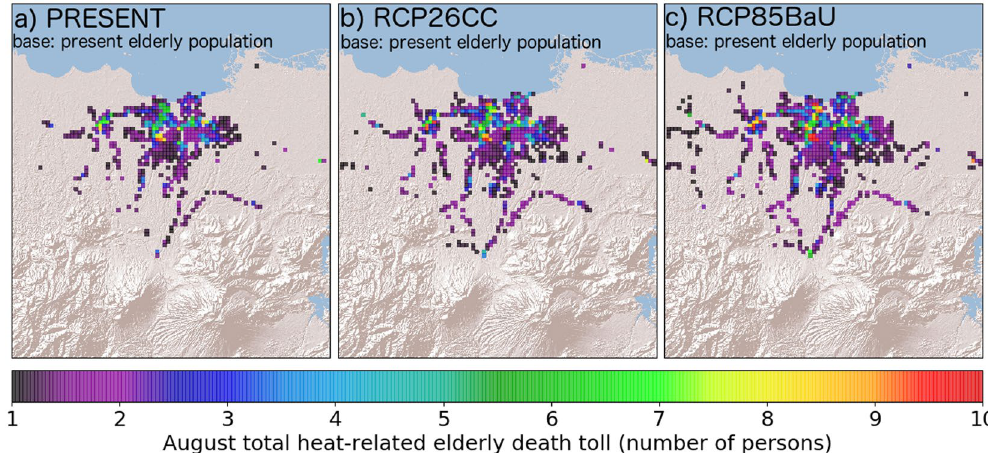
Figure 2. Estimated heat-related elderly mortality count when exposing the present-state population of elderly citizens to maximum temperatures simulated in ( a ) PRESENT, ( b ) RCP26CC, and ( c ) RCP85BaU cases for August months. Uncolored grids mean zero heat-related elderly deaths.